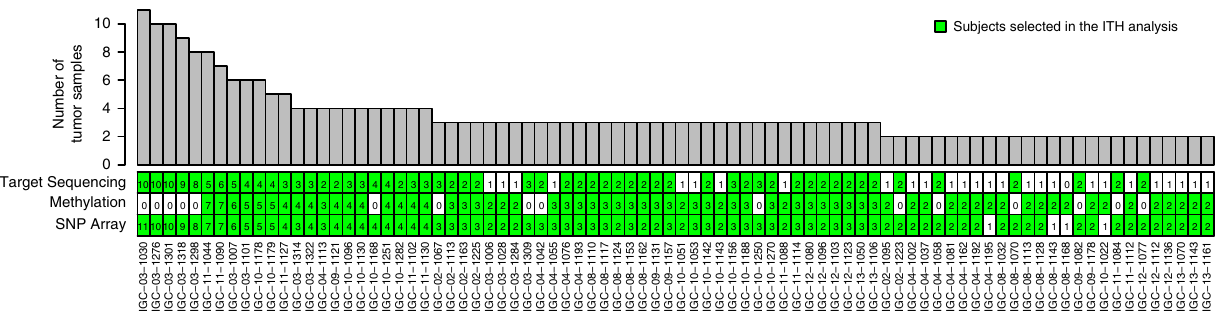
Fig. 1 Summary of subjects and tumor samples. Summary of tumor samples that were analyzed on different platforms: ultra-deep targeted sequencing of cancer driver genes (180 tumor samples from 56 subjects), genome-wide methylation (205 tumor samples from 68 subjects) or SNP array pro fi ling (268 samples from 80 subjects). Top panel (bar plot): the total number of tumor samples from each subject. Bottom panel (heatmap): the number of tumor samples from each subject pro fi led by different platforms. The green color indicates samples assayed by the speci fi c platform were selected for